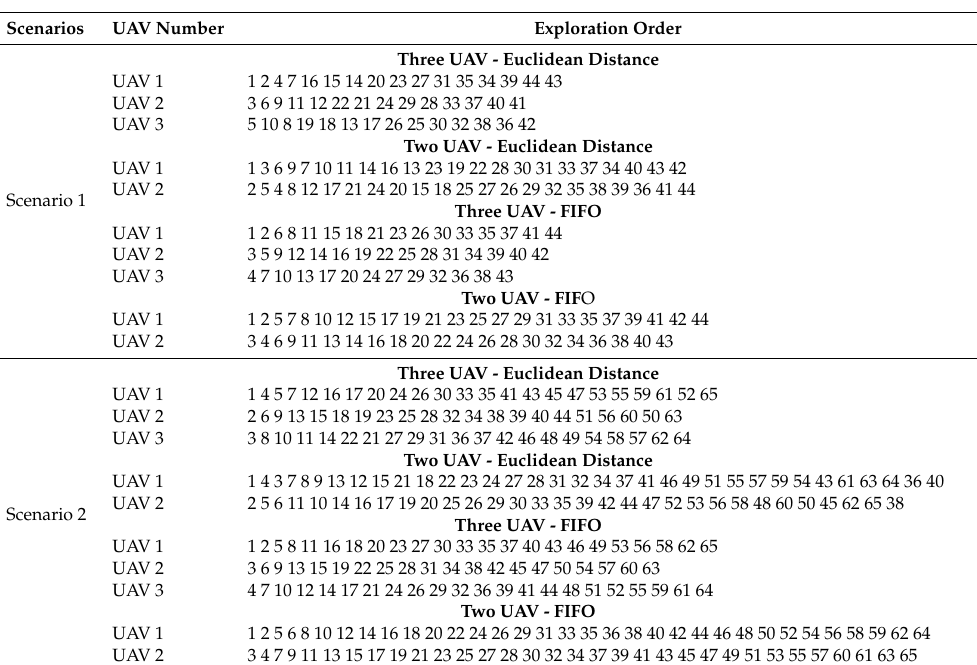
Table 5. Exploration order.